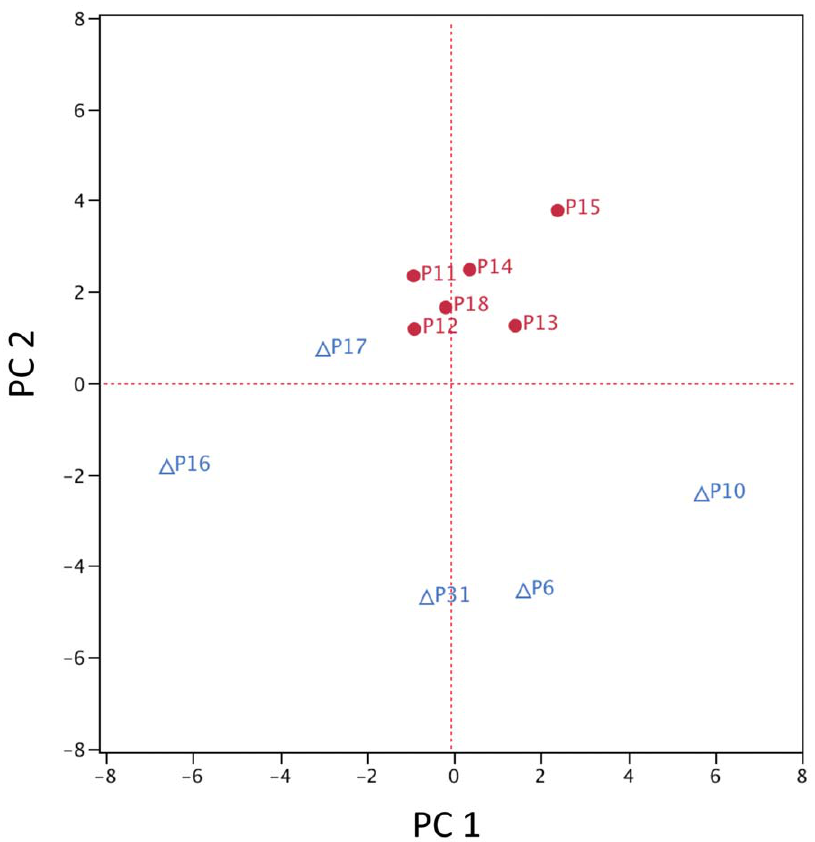
Figure 4. Principal Component Analysis by Genera. Patients with NoRSS are represented by red circles and those with RSS are represented with blue triangles. First principal component score (PC 1) vs. second principal component score (PC 2) plots the proportion of positive probes. Plot displays the first two principal components that represent 42.2% of the variability in the data matrix. NoRSS=patients who do not develop respiratory signs and symptoms. RSS=patients who develop respiratory signs and symptoms.